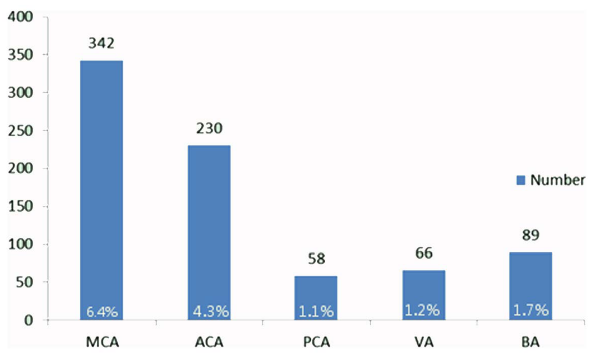
Figure 2. The number (percentages) of stenosis in each vessel segment. MCA: middle cerebral artery, ACA: anterior cerebral artery, PCA: posterior cerebral artery, VA: vertebral artery, BA: basal artery.